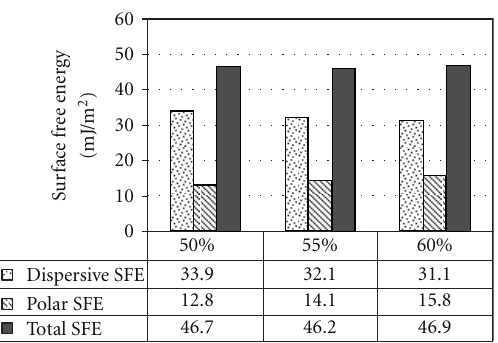
Figure 9: Dispersive ( γ D ), polar ( γ P ), and total ( γ TOT ) components of surface free energy (SFE) for the specimens with di ff erent vol. % of E-glass fibers calculated using the Owens-Wendt approach.